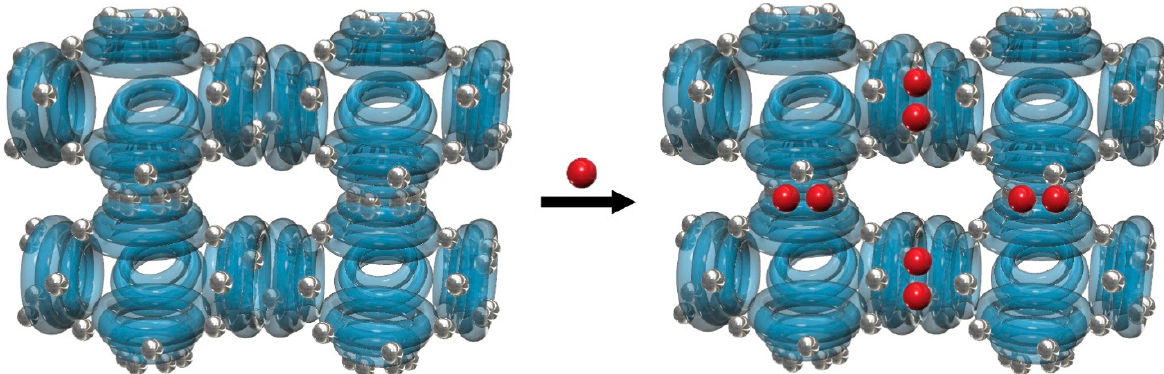
Figure 8. Cartoon representation of the encapsulation of fragrance within the pores of γ -CD-MOF . Big spheres represent the target scent, small spheres represent potassium ions, and semitransparent toroid-truncated cones represent γ -CD organic struts. The original results were reported by Zhou and coworkers [82].